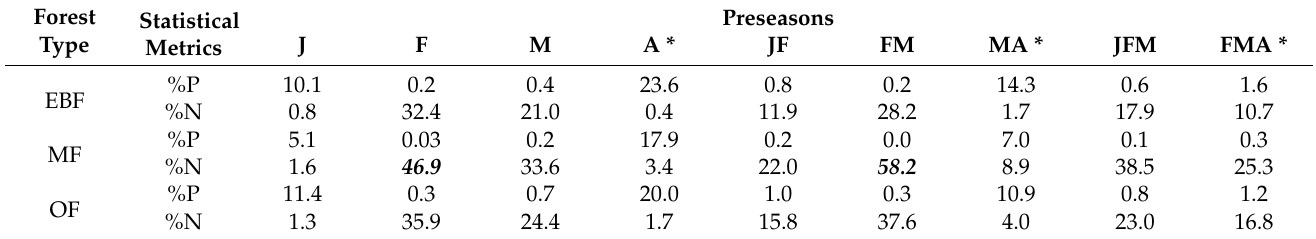
Table 3. Statistics of the Spearman partial correlation coefficients between SOS and mean air temperature for different forest types. EBF, evergreen broadleaf forests; MF, mixed forests; OF, open forests.